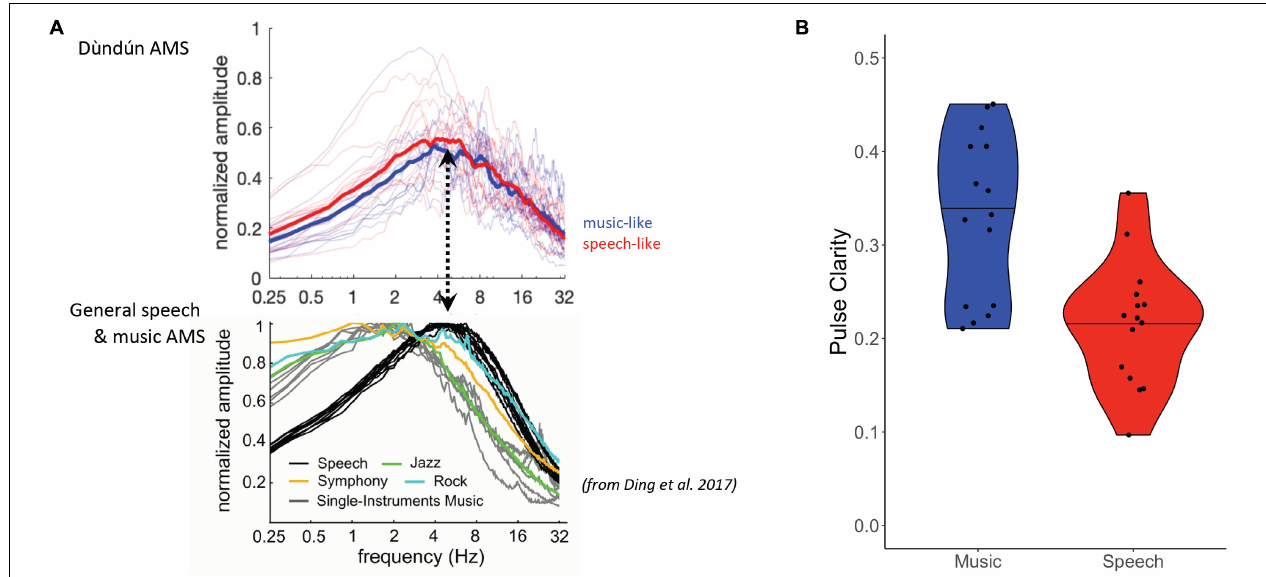
FIGURE 2 | (A) Amplitude modulation spectra of the dùndún performances (top panel). Thin lines are for AMS of individual recordings, thick lines represent the mean for 15 music (blue) and 15 speech-like (red) stimuli. Bottom panel shows AMS for speech and music corpora from Ding et al. (2017) for comparison. Dashed arrow illustrates that dùndún recordings peak at higher modulation rates than most Western music, namely rates that are typical for speech (black line) but also occur in rock music (teal line). The lower panel in A is reprinted from Neuroscience and Biobehavioral Reviews, 81, Nai Ding, Aniruddh D. Patel, Lin Chen, Henry Butler, Cheng Luo, David Poeppel, Temporal modulations in speech and music, 7, Copyright Elsevier Ltd. (2017), with permission from Elsevier. (B) Violin plots representing the pulse clarity of the music (blue) and speech-like (red) stimuli. The black horizontal line indicates the median of both distributions. Black dots represent pulse clarity for individual stimuli.